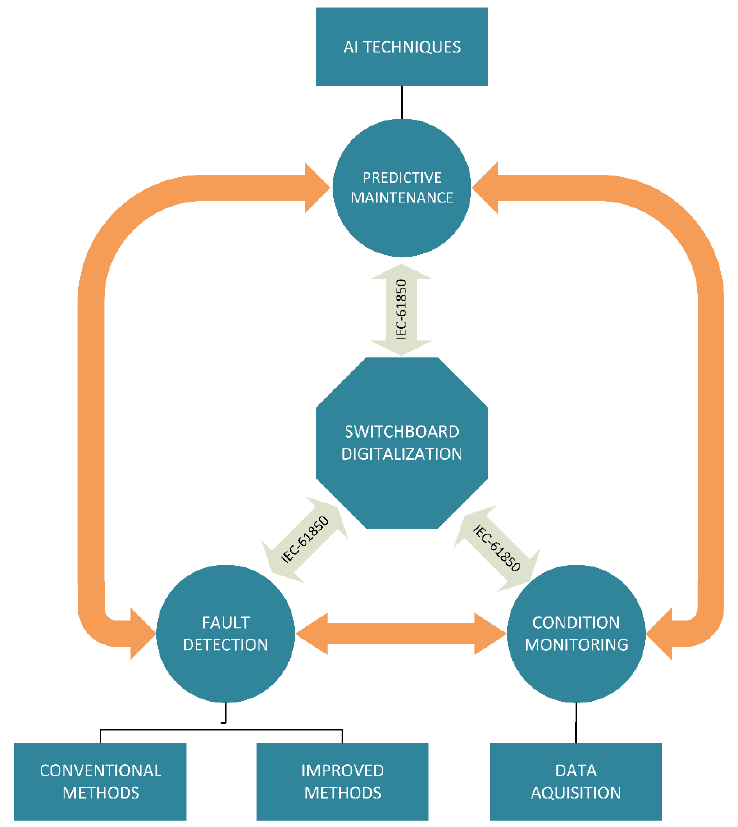
Figure 4. Interconnection of switchboard digitalization activities.